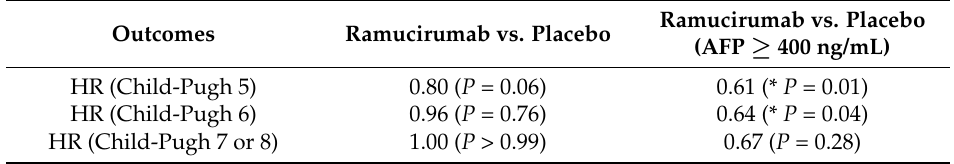
Results of a phase III clinical study to investigate ramucirumab in advanced hepatocellular carcinoma.